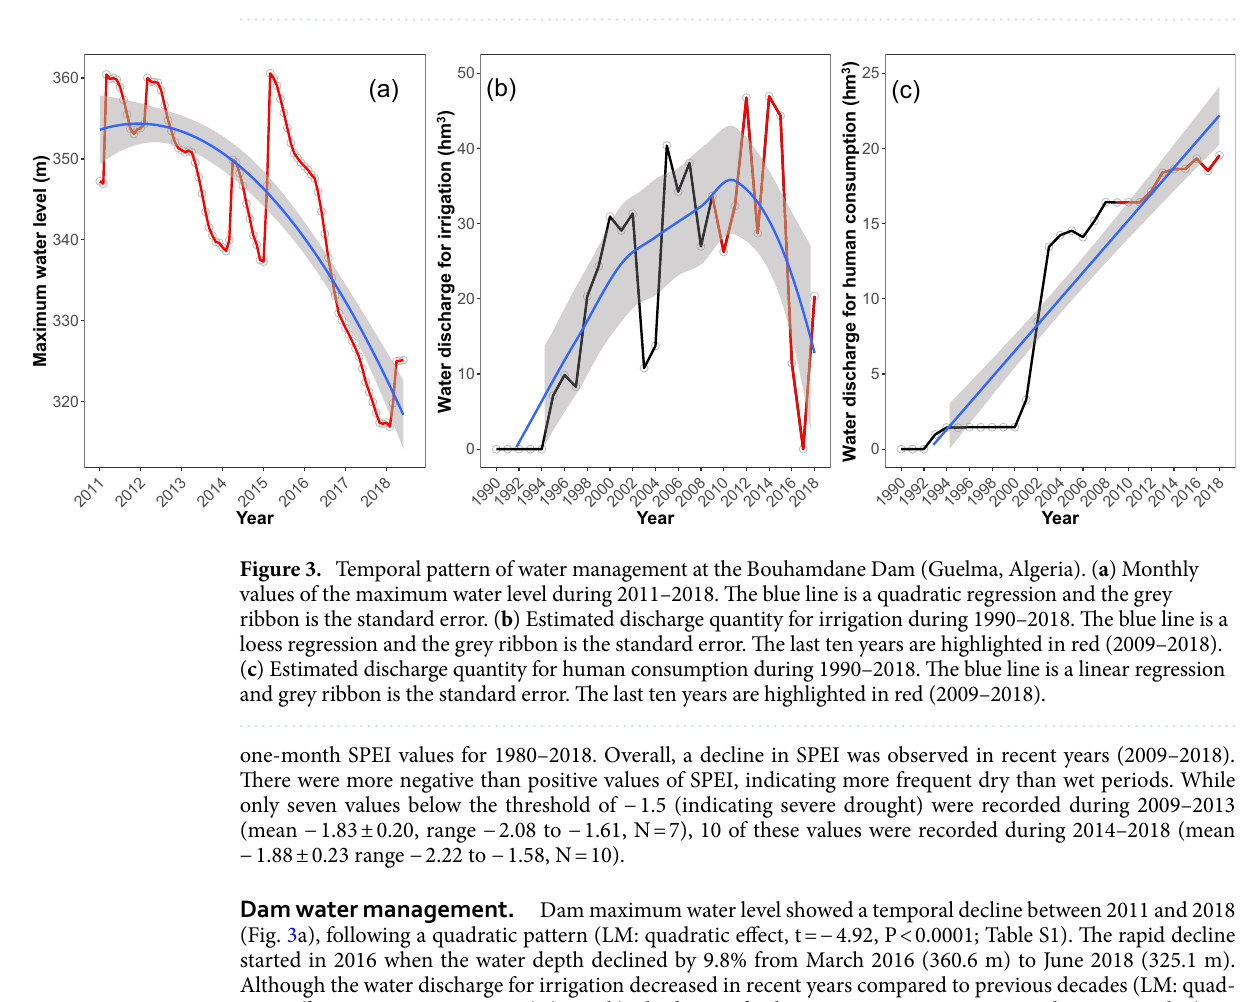
(Fig. 3a), following a quadratic pattern (LM: quadratic effect, t = − 4.92, P < 0.0001; Table S1). The rapid decline started in 2016 when the water depth declined by 9.8% from March 2016 (360.6 m) to June 2018 (325.1 m). Although the water discharge for irrigation decreased in recent years compared to previous decades (LM: quad- ratic effect, t = − 4.02, P = 0.0004) (Fig. 3b), discharges for human consumption increased continuously (LM: slope = 0.37 hm 3 year −1 , t = 7.02, P = 0.0001), albeit at a slower rate in the last decade (Fig. 3c).